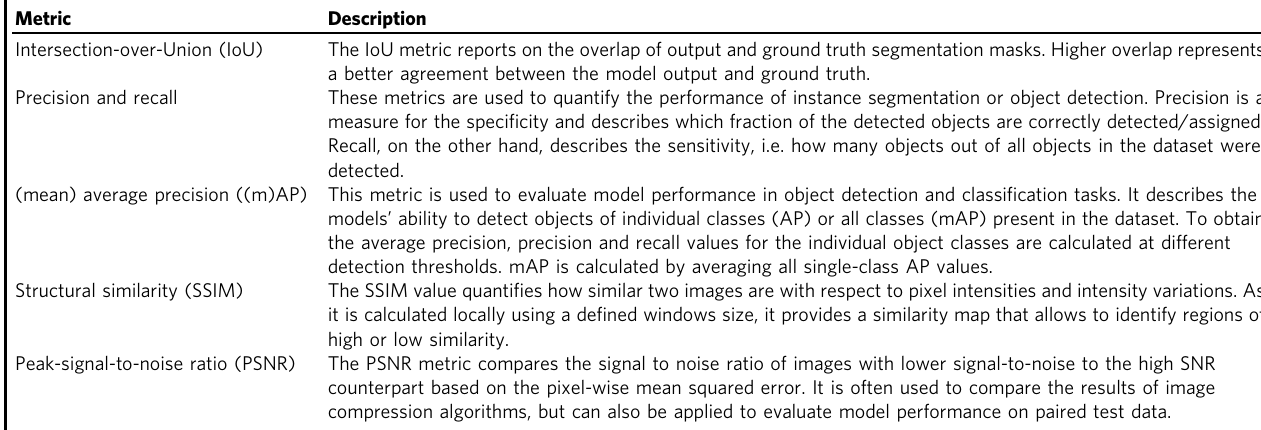
Table 2 Metrics to evaluate model